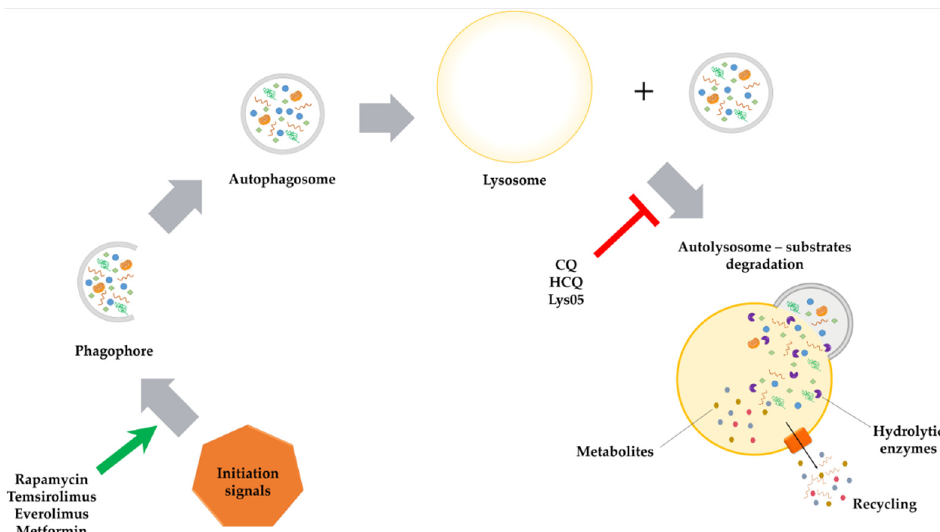
Figure 6. The influence of selected inhibitors or activators on autophagy process. Rapamycin, temsirolimus, everolimus and metformin via inhibition of initiation signals, stimulates autophagy process (marked with green arrow on the scheme). Chloroquine (CQ), hydroxychloroquine (HCQ) and Lys05 through blocking of autophagosome and lysosome fusion inhibits the autophagy (marked with red T-shaped sign on the scheme).